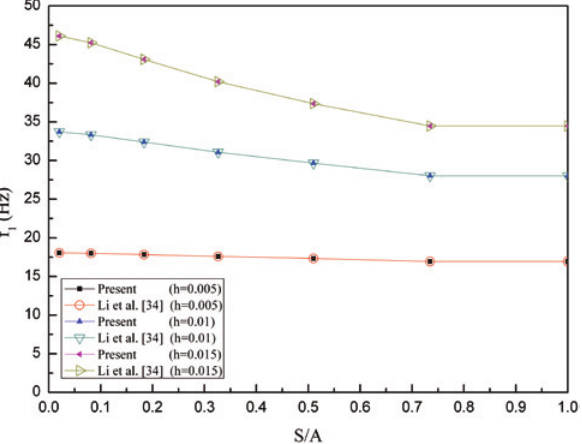
Figure 12 The third-order frequency of the clamped square com- posite laminates with different area of bonding imperfections.